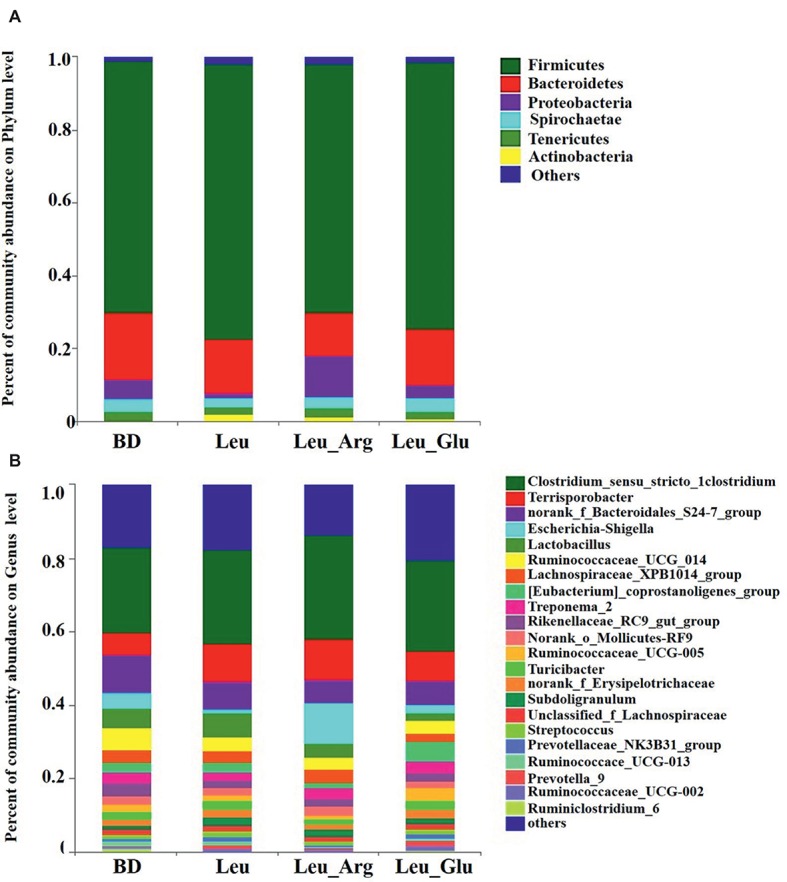
Colonic bacterial community structure of finishing pigs with different dietary treatment. Distribution of colonic bacteria at phylum (A) and genera (B) levels in finishing pigs. Phylum and genera with proportion less than 0.01 are not listed.